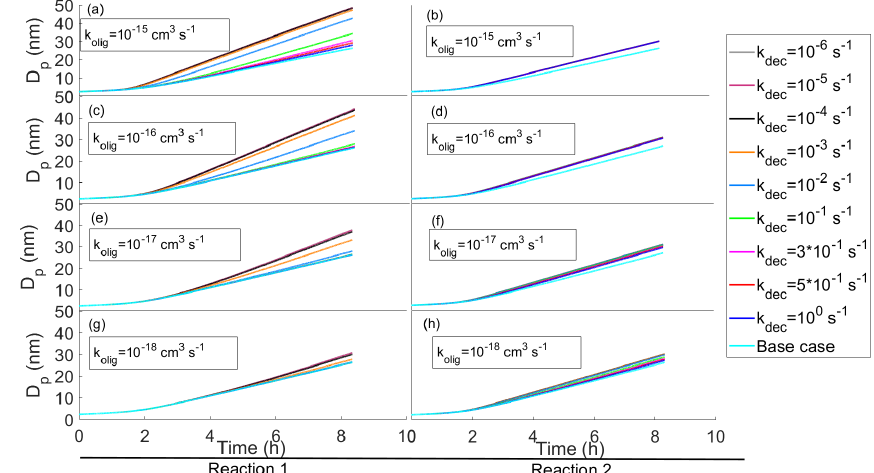
Figure 7. Diameter of the particle as a function of time with reversible oligomerization reactions with different oligomerization and decom- position reaction rates. In each subplot simulations with the same oligomerization reaction rate and with different decomposition reaction rates are presented. The oligomerization reaction rates decrease when ascending with subplots. On the left column of panels (a, c, e, g) the simulations have a reaction in which two SVOCs from the two highest volatility bins ( C ∗ = 10 2 and 10 1 µgm − 3 ) form an ELVOC ( C ∗ = 10 − 4 µgm − 3 ), and on the right column of panels (b, d, f, h) the simulations have a reaction in which a SVOC and LVOC ( C ∗ = 10 1 and 10 − 2 µgm − 3 ) form an ELVOC ( C ∗ = 10 − 4 µgm − 3